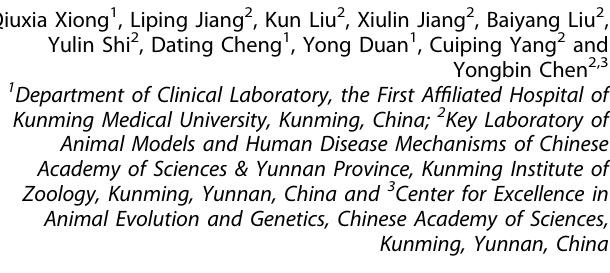
Fig. 1 miR-133b targets NCAPH to promote β -catenin degradation and reduce cancer stem cell maintenance in NSCLC. a Signi fi cant differential expression of NCAPH between tumor and normal tissues from lung (GEO accession code: GSE31552). b NCAPH high expression in NSCLC leads to signi fi cant worse survival rate than its low expression patients by Kaplan – Meier survival analysis. c Expression levels of NCAPH in lung cancer patients with different disease stages. d Both NCAPH mRNA (top) and protein (bottom) were increased in NSCLC cell lines: H1299, A549, H1975, SPC-A1, H838, and GLC-82, compared to normal human bronchial epithelial cell line: BEAS-2B. e, f Establishing NCAPH knockdown and overexpression cell lines in A549, veri fi ed by Real-time RT-PCR ( e ) and western blot ( f ). Green arrow: exogenous NCAPH-Flag; red arrow: endogenous NCAPH. Gray box: Untreated blank control. g, h NCAPH knockdown in A549 dramatically inhibited cell proliferation ( g ) and colony formation ( h ), quanti fi cation data for ( h ) is also indicated. i Binding sites of NCAPH 3 ′ -UTR sequences with miR-133b seed sequences predicted by TargetScanHuman. j miR-133b targets NCAPH veri fi ed by dual-luciferase reporter assay. k Overexpressions of miR- 133b mimics or inhibitor suppressed or promoted, respectively, A549 cell proliferation determined by growth curve. l Xenograft tumors are photographed, which were harvested from A549 cells after tumors had grown for 8 weeks. m, n miR-133b overexpression signi fi cantly reduced xenograft tumor mass ( m ) and tumor volume ( n ) in nude mice. o, p NCAPH knockdown inhibited expressions of stemness marker genes in A549 examined by Real-time RT-PCR ( o ) and western blot ( p ). q, r NCAPH knockdown decreased membrane-tethered CD133 expression in A549 veri fi ed by fl ow cytometry analysis after stained with CD133-PE. ( r ) is the quanti fi cation of ( q ). s Indicated cell lysates were examined by western blot in A549 detecting phosphorylation on β -catenin. t To detect the complex formation among NCAPH, Akt1, and β -catenin, HEK-293T cells were transfected with indicated plasmids and the cell lysates were used for co-IP and western blot. u Working model for miR-133b/NCAPH axis in NSCLC. Under normal conditions, high level of miR-133b targets NCAPH mRNA and inhibits NCAPH expression. Decreased NCAPH proteins cannot inhibit Akt1/ β -catenin complex formation ef fi ciently, resulting in phosphorylation at ser552 site on β -catenin leading to its protein degradation through ubiquitin proteasome pathway, which in turn reduces the activity of Wnt signaling pathway. However, under pathological conditions, decreased miR-133b promotes the high expression of NCAPH. Abundant NCAPH proteins compete with Akt1 to interact with β -catenin physically, which leads to stabilization of β -catenin and then constitutive activation of Wnt signaling. Therefore, the self-renewal ability of cancer stem cells in NSCLC is increased, which promotes NSCLC cancer progression and